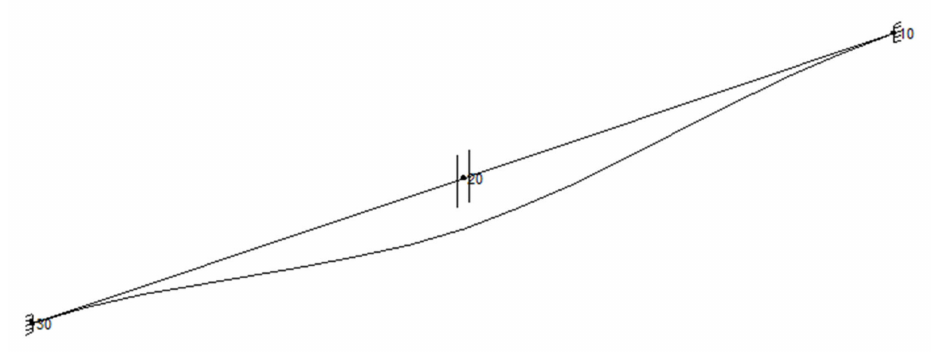
Figure 2. Example of graphical results: pipeline deflection for L = 1850 mm.